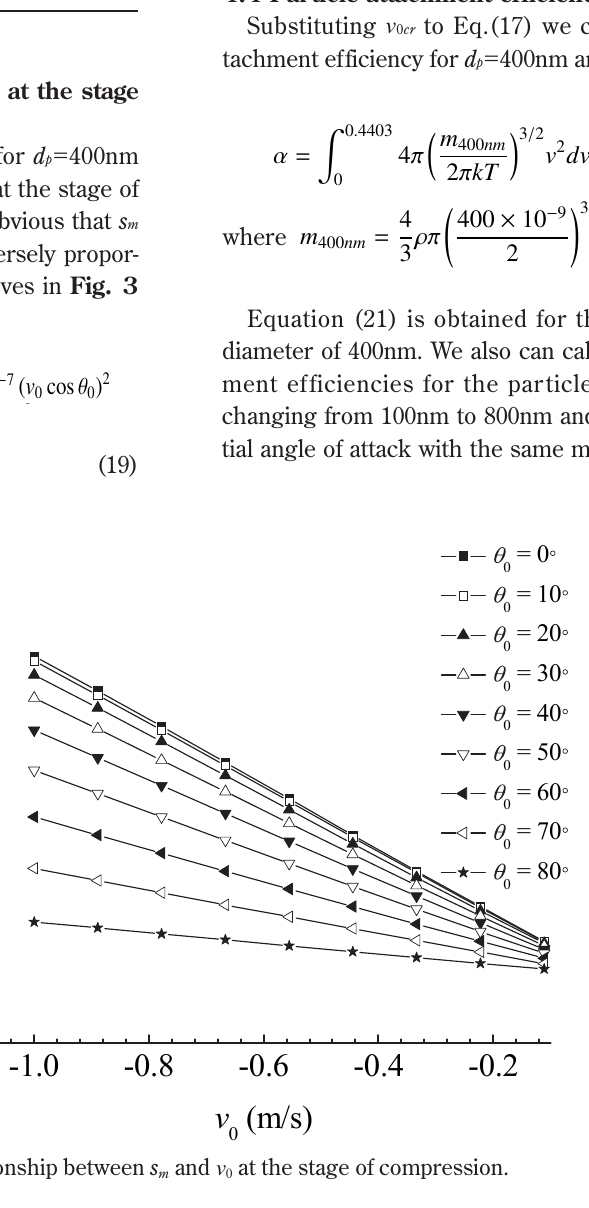
Fig. 3 Relationship between s